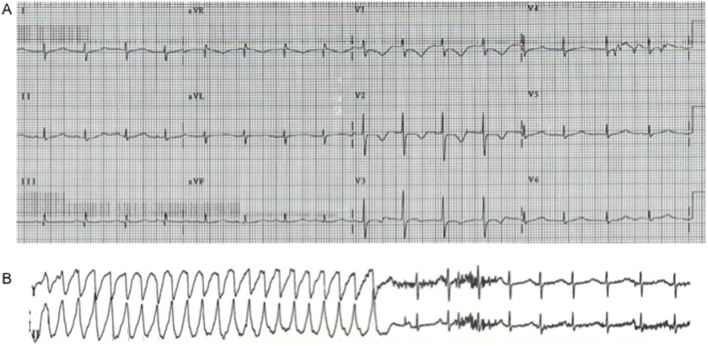
Long QT and ventricular tachycardia.A: Baseline electrocardiogram showing prolonged QT interval. The heart rate is 97. The QTc is 504 ms. The ECG was recorded at 25 mm/s. B: Leads I and II showing monomorphic ventricular tachycardia on an ECG rhythm strip recorded in the Emergency Department.